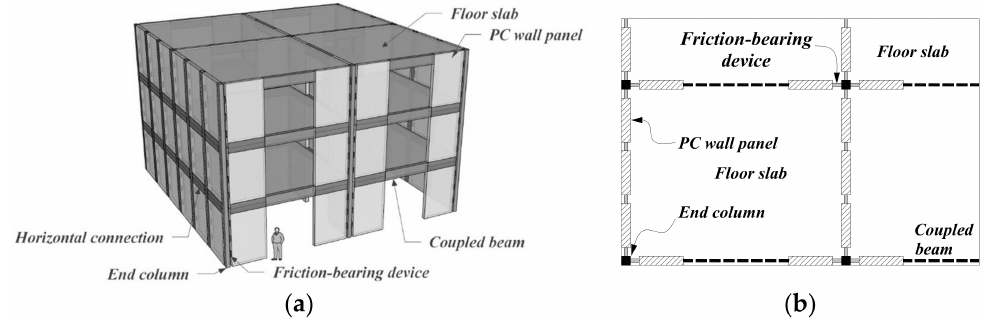
Figure 4. Proposed PC shear wall system [22]. ( a ) 3D view; ( b ) Plan